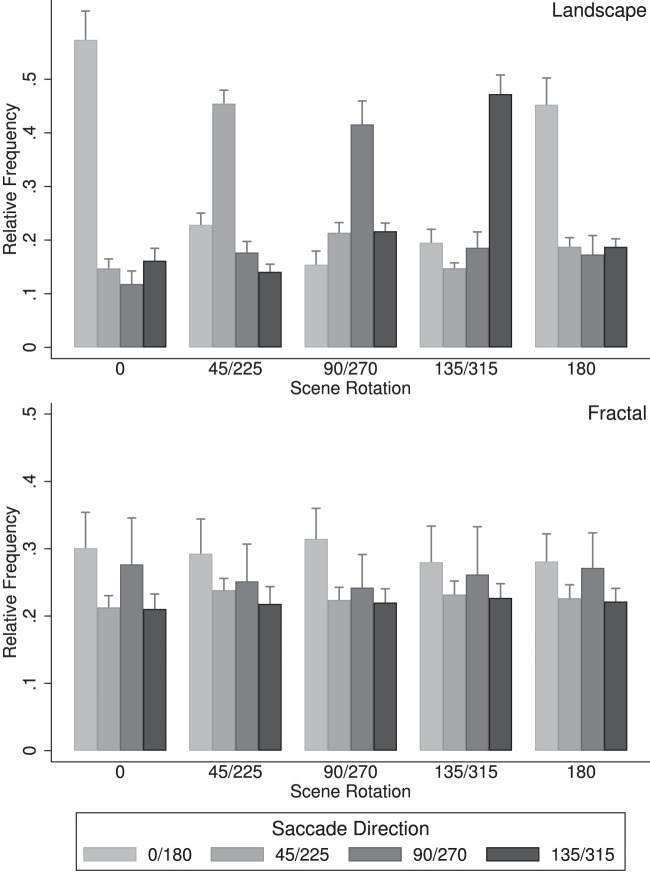
Head shift directions organized into four symmetric axes in world coordinates, for landscape scenes (top) and fractal scenes (bottom). Data show the mean proportions and standard errors of head shifts along the four head shift axes (0°/180°, 45°/225°, 90°/270°, and 135°/315°) and the five scene rotation groups (0°, 45°/225°, 90°/270°, 135°/315°, and 180°).